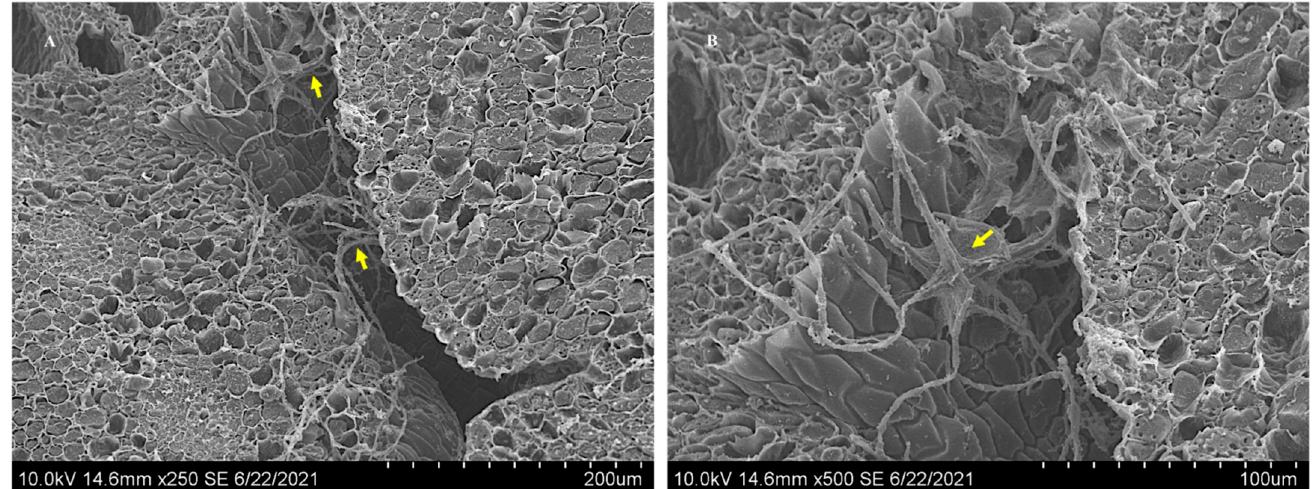
Figure 7. Scanning electron microscope images illustrating fungal growth between the gaps of the hypocotyl and the cotyledons of positive Ipomoea carnea seed indicated by the arrows ( A ). The mycelia that appears on the top surface is an artifact of sectioning. A magnified image × 500 of the hypocotyl region shows that mycelia are restricted to the gaps and do not penetrate the plant cells ( B ).